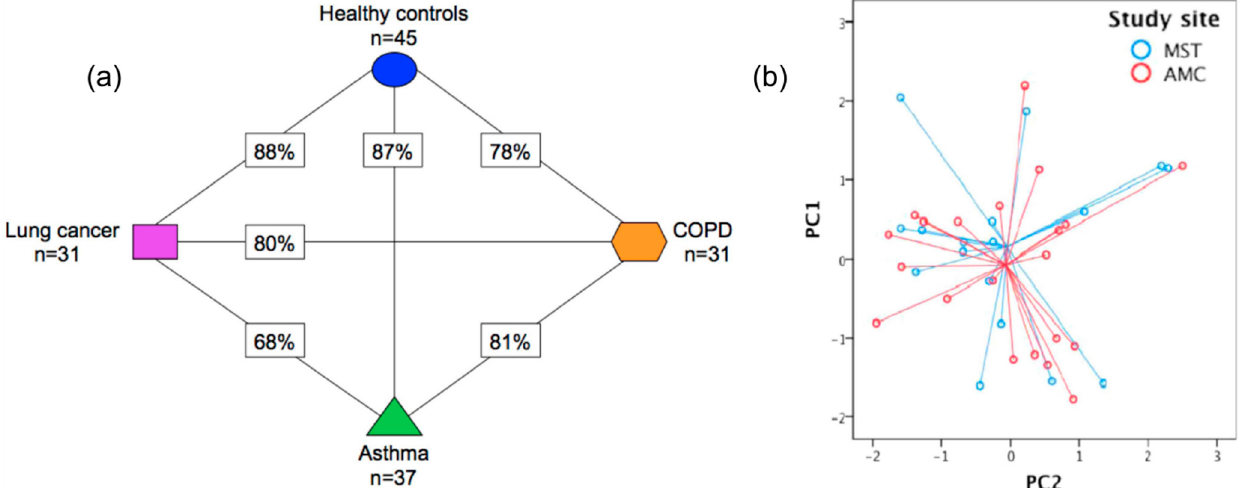
Figure 14. ( a ) Presentation of the cross-validation percentages of the differentiation of asthma, COPD, LC patients, and HC, using SpiroNose; ( b ) PCA plot of breathprints collected from asthmatic patients at the Academic Medical Center (AMC), Amsterdam and Medical Spectrum Twente (MST), Enschede, for which no significant differentiation is observed ( p = 0.892). Adapted with permission from Ref. [91]. Copyright © 2015 IOP Publishing Ltd.